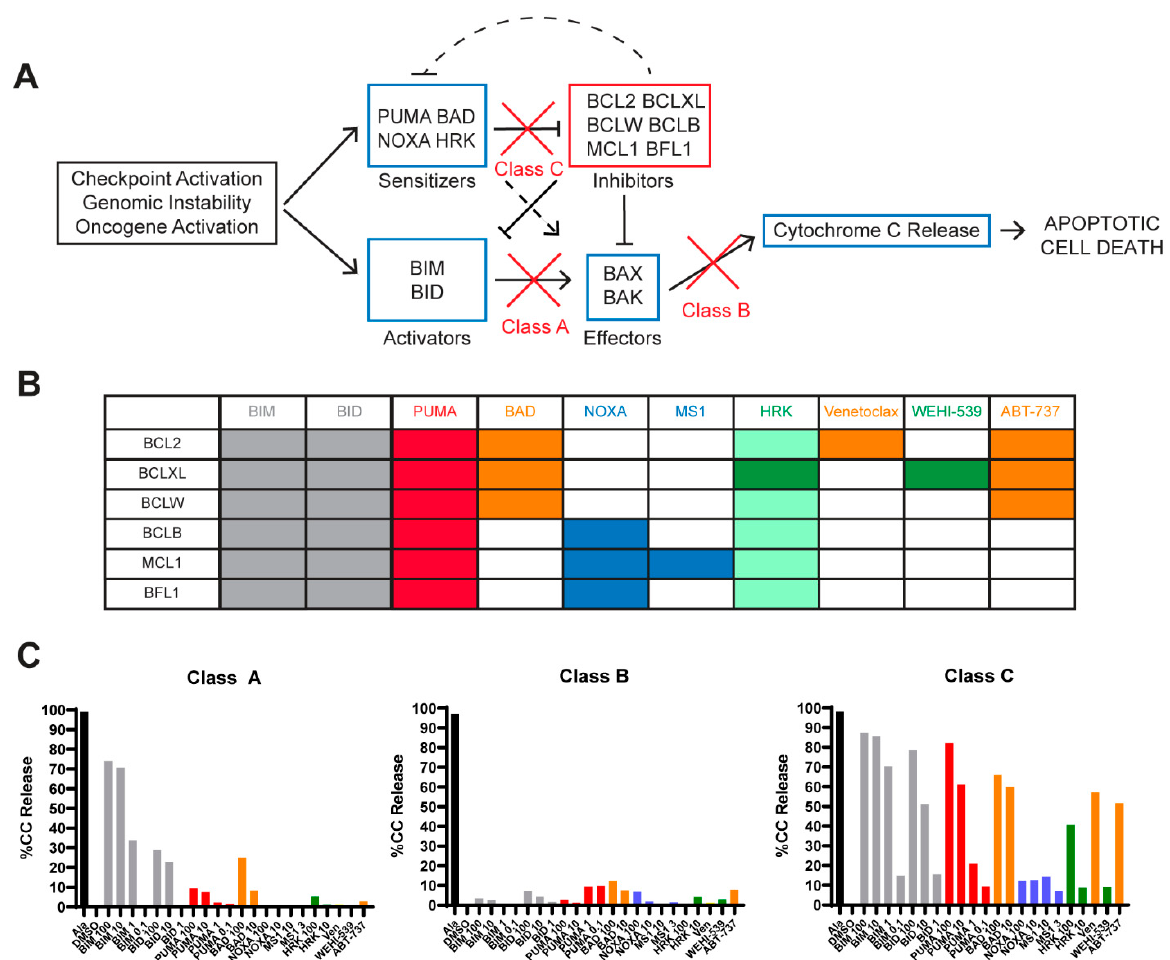
Figure 1. BH3 profiling assay: rationale and methodology. (Adapted from Deng et al. [16]). ( A ) Anti-apoptotic BCL2 family members inhibit the mitochondrial apoptotic pathway. Upon oncogene activation or cellular damage, activator and/or sensitizer proteins are upregulated, which allows BAX and BAK to oligomerize, leading to cytochrome c release, which results in apoptotic cell death. Anti-apoptotic BCL2 family members inhibit pro-apoptotic and sensitizer proteins, preventing BAX and BAK from inducing mitochondrial outer membrane polarization (MOMP), the commitment to apoptosis. ( B ) Pattern of interaction between the anti-apoptotic proteins (rows) present in cells and the pro-apoptotic synthetic peptides or drugs (columns) used in the BH3 profiling assay. PUMA (illustrated by red columns) inhibits all the inhibitors and is a pan-sensitizer, as well as contributing to BAX and BAK activation. Orange colors indicate peptides that inhibit the BCL2 protein with venetoclax inhibiting only BCL2 whereas BAD and ABT-737 inhibit BCL2, BCLXL, and BCLW. Blue columns are used to highlight mantle cell lymphoma (MCL)1-dependence where MS1 specifically inhibits MCL1, whereas NOXA inhibits BCLB, MCL1 and BFL1. Green columns indicate BCL-XL-dependence where WEHI-539 only inhibits BCLXL and HRK is mainly a BCL-XL inhibitor but can also inhibit other anti-apoptotic proteins with lower affinities, including BCL2. ( C ) BH3 profiles are illustrated in graphical form with % of the cells undergoing cytochrome c release on the Y axis after exposure to each drug/peptide on the X axis. Alamethecin (ALA) is a control that induces cytochrome c release in all cells independent of BAX or BAK. DMSO is the negative vehicle control because it does not induce cytochrome c release. Representative samples from our cohort were used to demonstrate different classes of apoptotic block. This high-grade B cell lymphoma with translocations in MYC and BCL2 (HGBL-DH) sample shows a class A block, where cells were competent to undergo apoptosis (i.e., functional BAX/BAK) because exogenous activators BIM and BID could induce MOMP (grey bars). Two diffuse large B-cell lymphoma (DLBCL) samples shown here represent a class B and C BH3 profile. In class B blocks, cells fail to undergo MOMP upon exposure to BIM or BID BH3 synthetic peptides, indicating that there is no functional BAX or BAK, and are incompetent for undergoing apoptosis through the mitochondrial pathway. In class C blocks, cells are competent to undergo apoptosis (grey BIM/BID), primed (red PUMA) and depend mainly on BCL2 (orange